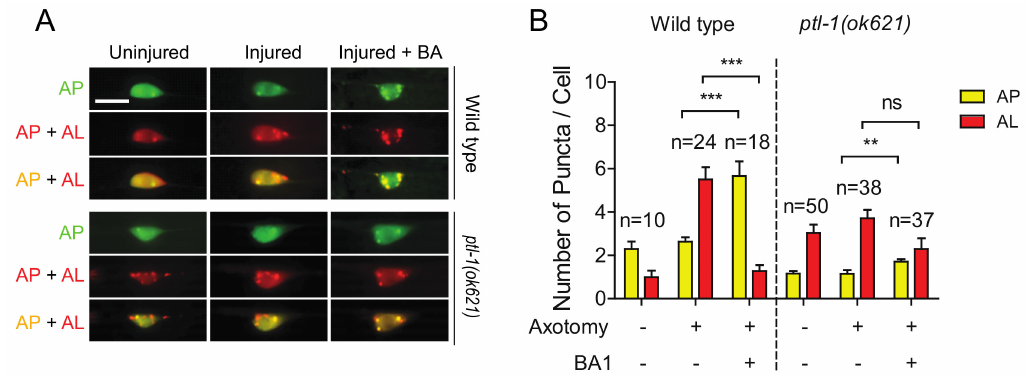
Figure 6. The high basal level of autolysosomes in the ptl-1 mutant is less sensitive to BA1 compared to wild type. ( A ) Representative images of both wild-type and pt1-1(ok621) transgenic PLM cell bodies, expressing P mec-4 -mCherry::GFP::LGG-1, 24 h post axotomy. Images taken with and without injection of 50 µ M of BA1 into tail region. Treatment occurred at day 1 of adulthood 1 h before axotomy. BA1 suppressed autolysosome formation in injured wild-type neurons, but not in ptl-1(ok621) mutants. Scale bar: 10 µ m. ( B ) Quantification of APs and ALs in PLM cell bodies for experiments in ( A ). Statistics: one-way ANOVA; mean ± SEM; ** p < 0.01; *** p < 0.001; ns, Not